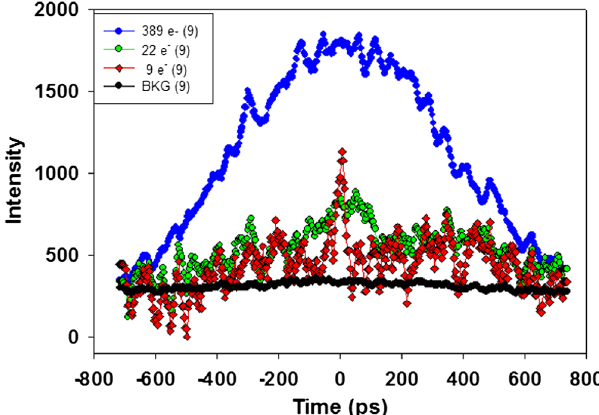
FIG. 9. A comparison of the observed longitudinal distributions for 389, 22, and 9 e- stored with a nine-channel smoothing (9) done on all profiles and 200-image summing used. The ends of the three distributions were matched with the background (BKG) intensity. The central peak near 0 ps in the 10 e − case is statistically significant.